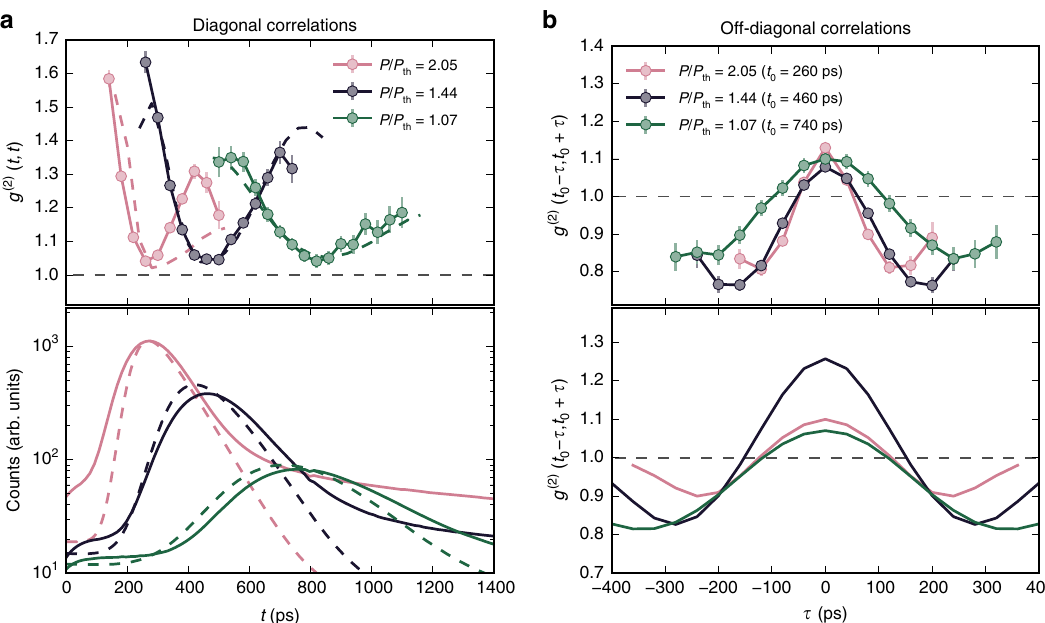
Fig. 6 Diagonal and off-diagonal correlations. Cuts through the regions depicted by the dashed lines in Fig. 5. a Diagonal correlations, g (2) ( t , t ), shown on top, and the average condensate pulse, shown on the bottom. The full and dashed lines depict the experimental data and the quantum trajectories results, respectively. b Off-diagonal correlations, g (2) ( t 0 − τ , t 0 + τ ), with t 0 the peak time of the average condensate pulse. Top depicts the experimental results, with the quantum trajectories simulation on the bottom. Here, the theory slightly deviate from the experimental results, which may be attributed to the error that propagates from determining the peak time t 0 .